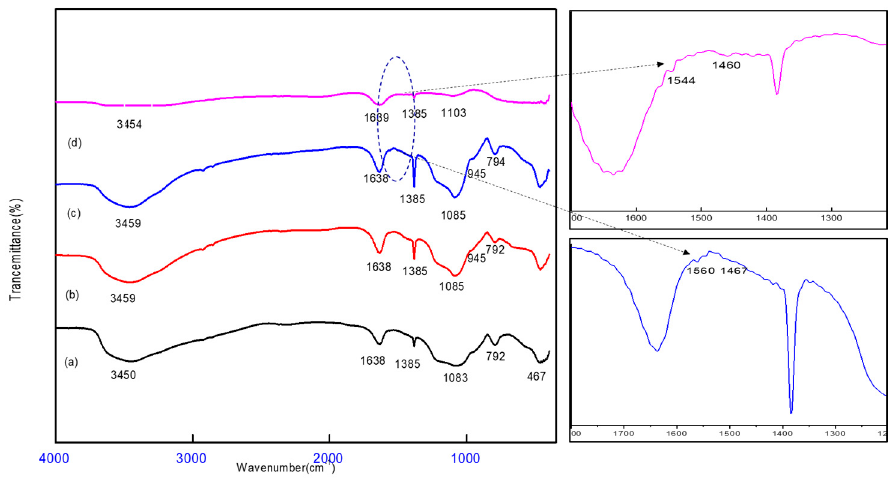
Figure 1. FTIR spectra of ( a ) nano-silica-coated oxyhydroxide aluminum (SCB), ( b ) Ni-sorbed SCB, ( c ) nano-silica-coated oxyhydroxide aluminum doped polyaniline (SBDP), ( d ) Ni-sorbed SBDP